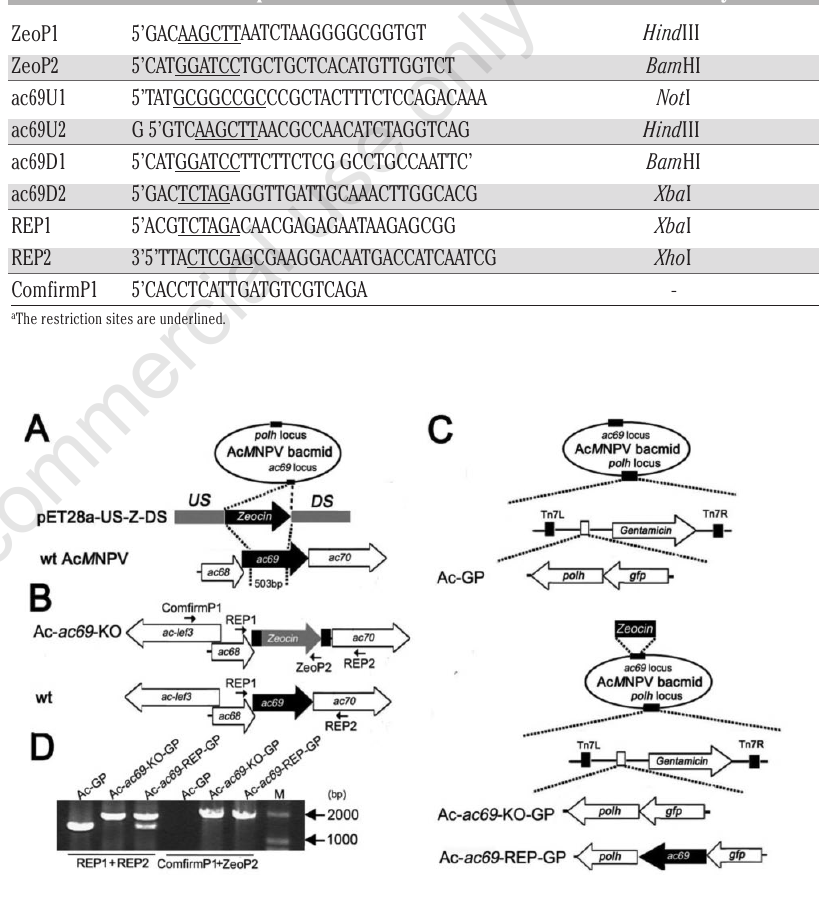
Figure 1. Construction of ac69 knockout, repair, and wt AcMNPV bacmids containing gfp and polyhedrin . (A) Schematic diagram for construction of an ac69 knockout bacmid containing a deletion of the ac69 gene by recombination in E.coli. A 503-bp fragment of the ac69 orf was deleted and replaced by the Zeocin resistance gene under the control of the EM7 promoter. (B) Diagram indicating the positions of primer pairs used in the con- firmation of disruption of ac69 and the correct insertion of Zeocin resistant gene in ac69 locus. (C) Schematic diagram of three viruses, Ac-GP, Ac- ac69 -KO-GP and Ac- ac69 -REP- GP, showing the polyhedrin and gfp genes inserted into the polyhedrin locus by Tn7- mediated transposition. (D) Confirmation by PCR analysis of the presence or absence of sequence modifications among each bacmid (Ac-GP, Ac- ac69 -KO-GP and Ac- ac69 -REP- GP). The virus templates are shown above each lane, and the primer pairs used are shown below.